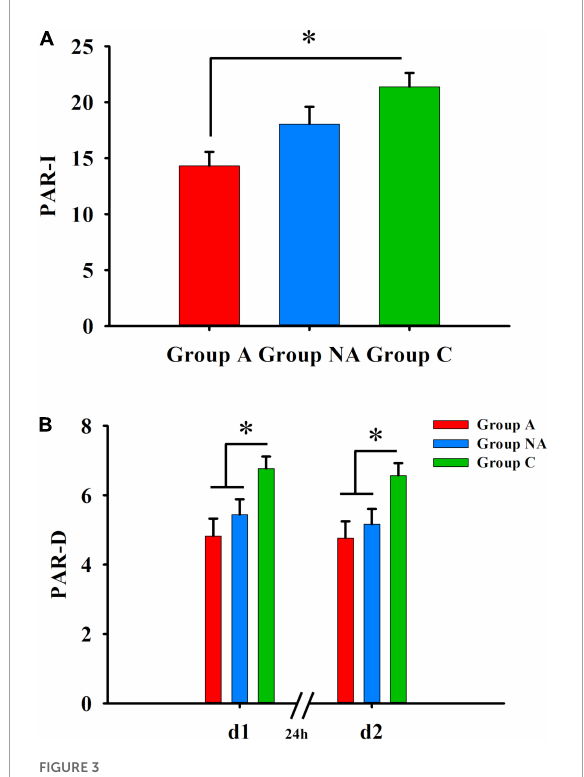
FIGURE3 Declarative memory. (A) Differences in PAR-I among A, NA, and C groups (Kruskal–Wallis test, Bonferroni correction. ∗ P = 0.002). (B) Differences in delayed cued-recall (PAR–D) PAR-d1 and PAR-d2 among A, NA, and C groups (Kruskal–Wallis test, Bonferroni correction. ∗ P s ≤